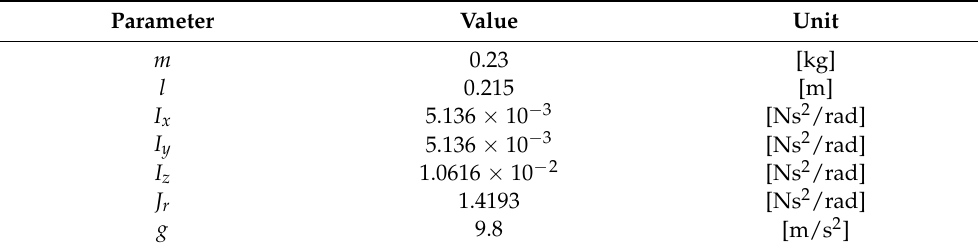
Table 1. Numerical parameters of quadrotor